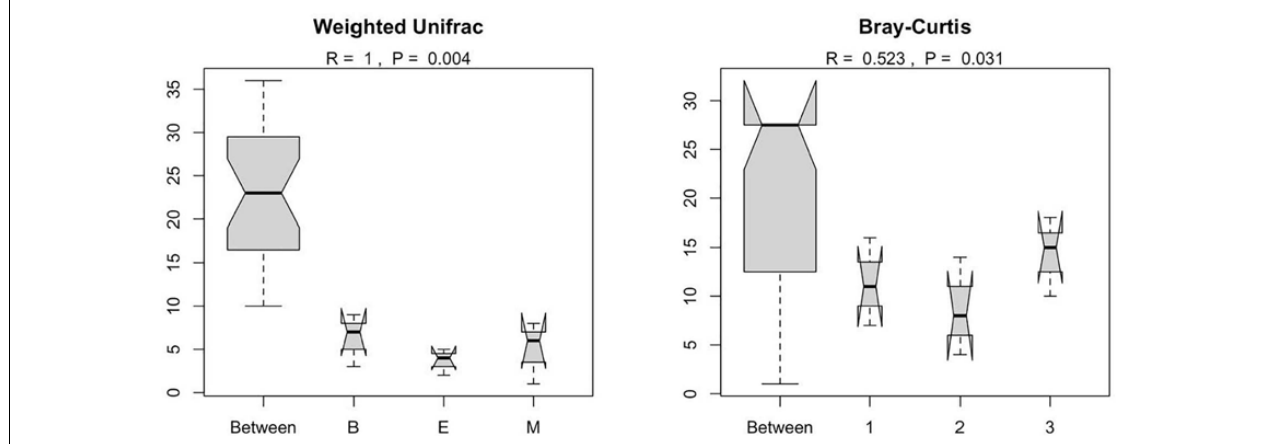
FIGURE 8 | Results of ANOSIM showing the statistical significance of differential prokaryote community structure (based on weighted UniFrac and Bray–Curtis) between wetlands and primers; The abbreviations and numerics used are as follows: B, Bhomra; E, EKW; M, Malencho; 1, 341b4_F/806_R; 2, N341b4_F/806_R; 3, Pro341F/Pro805R; EKW, East Kolkata wetland.